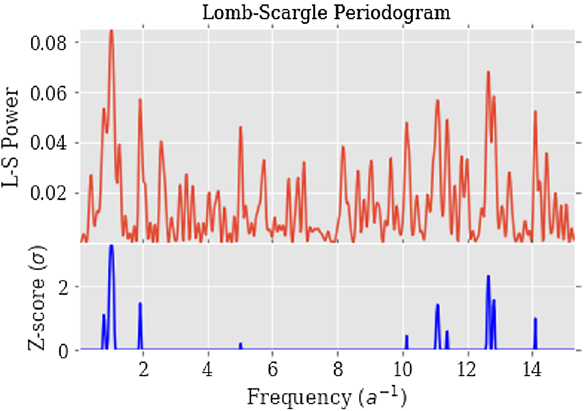
Fig. 4 Weighted L–S periodograms of 36 Cl decay rate data measured at the BNL (top panel) for frequencies in the range 0–14 a − 1 ). The bottom panel shows the Z-scores greater than zero (obtained from p value calculated via the Baluev method) for different frequencies